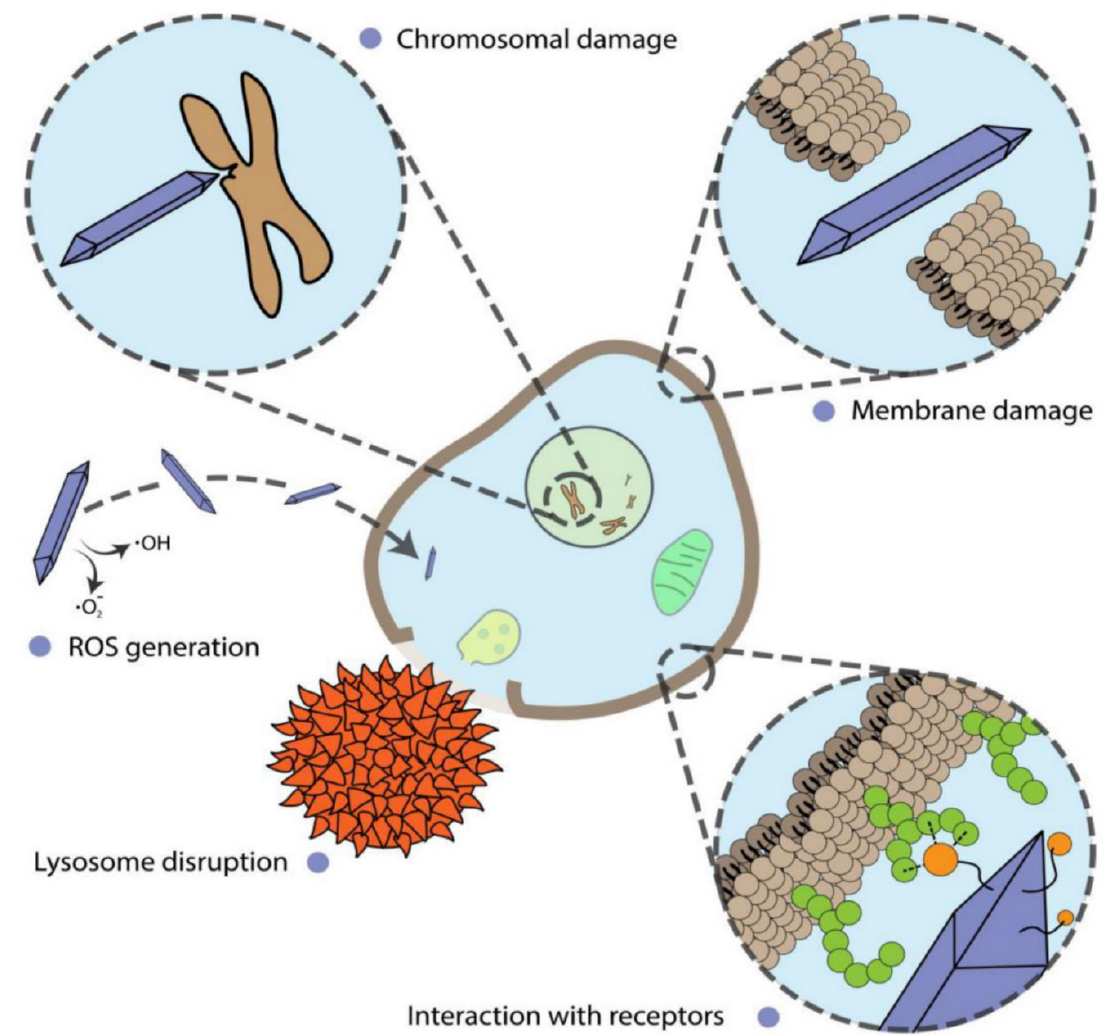
Figure 6. Various mechanisms of nanoparticles influence on cells [135].